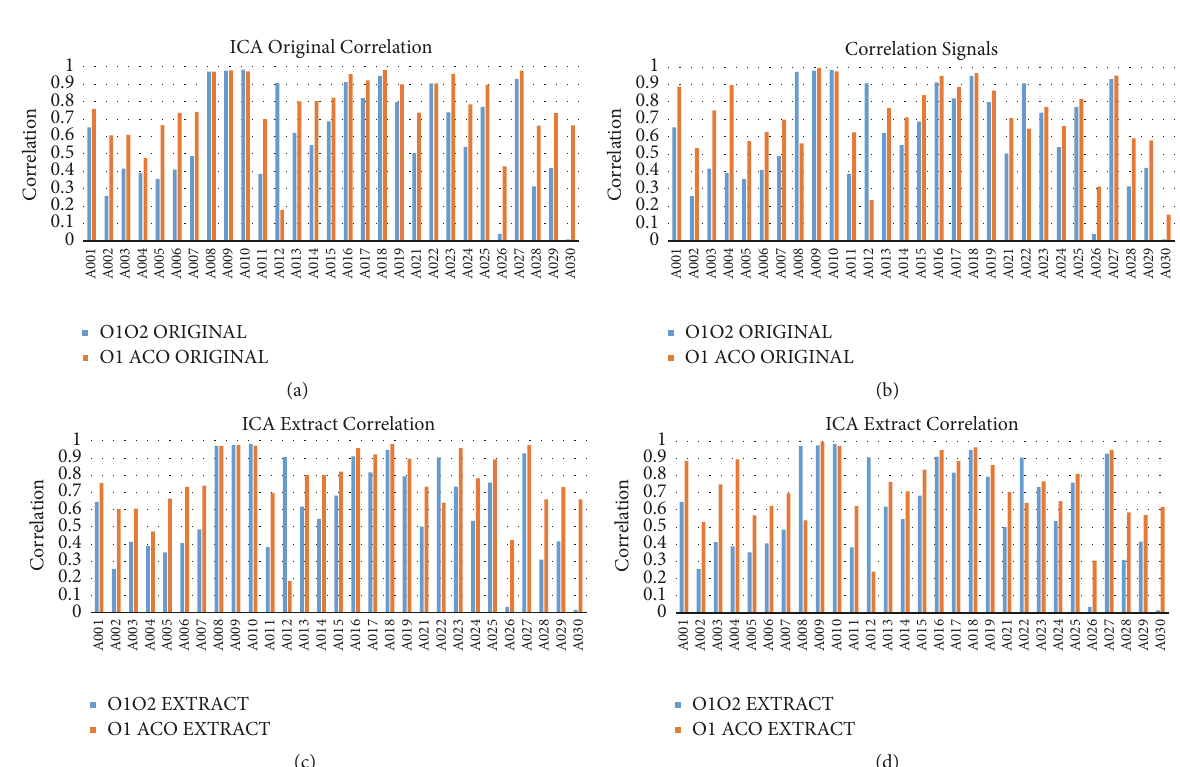
Figure 32: Signals correlation. (a) Original signals O1-O2 versus O1-ACO. (b) Original signals O1-O2 versus O2-ACO. (c) Reconstructed signals O1-O2 versus O1-ACO. (d) Reconstructed O1-O2 versus